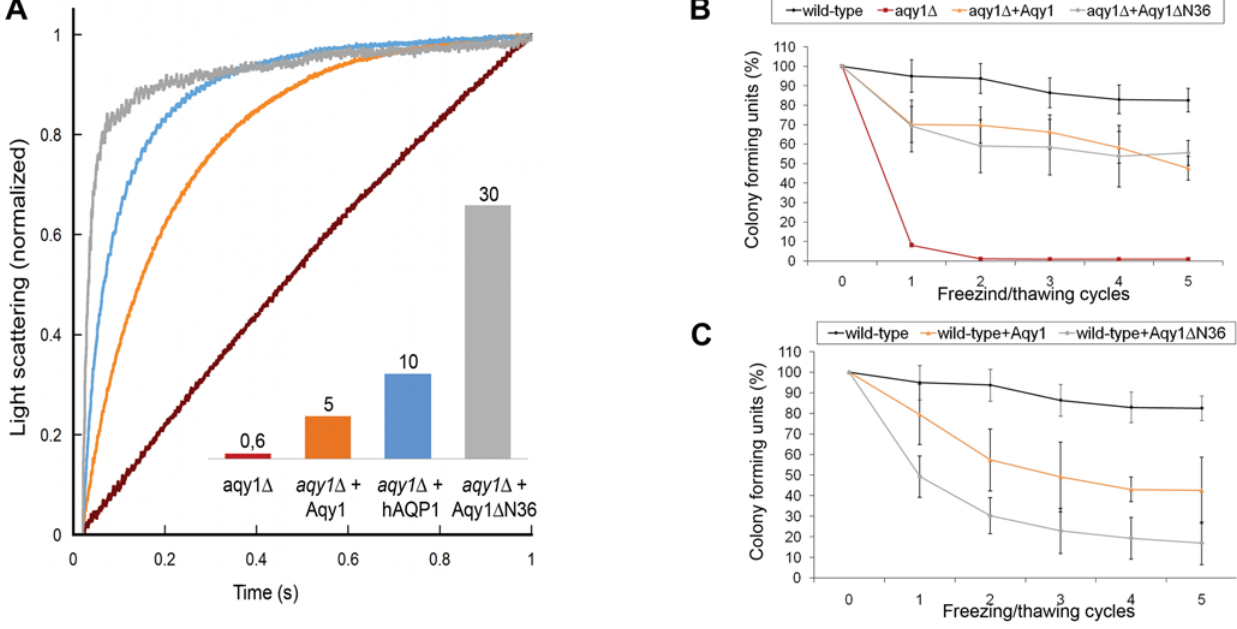
Figure 4. Water transport activity and growth assays on Aqy1. (A) Water transport activity measured by the change of light scattering of P. pastoris spheroplasts upon shrinkage caused by subjecting the cells to a hyperosmolar solution. Aqy1 (orange), hAQP1 (blue), and Aqy1 D N36 (grey) were overproduced in the aqy1 D -strain (red, endogenous AQY1 gene disrupted). The inset shows the rate constants (s 2 1 ); the curves were smoothened for clarity. (B) Relative number of P. pastoris colony forming units (CFU) following multiple freeze/thaw cycles ( x -axis) of the wild-type strain (black), P. pastoris with the AQY1 gene disrupted ( aqy1 D ) (red); aqy1 D overproducing Aqy1 (orange) and Aqy1 D N36 (grey). (C) Similar experiments as in (B) but using wild-type P. pastoris strain (black) and overproducing recombinant Aqy1 (orange) and Aqy1 D N36 (grey). The recombinantly overproduced proteins negatively impact survival, with Aqy1 D N36 having a significantly larger effect.